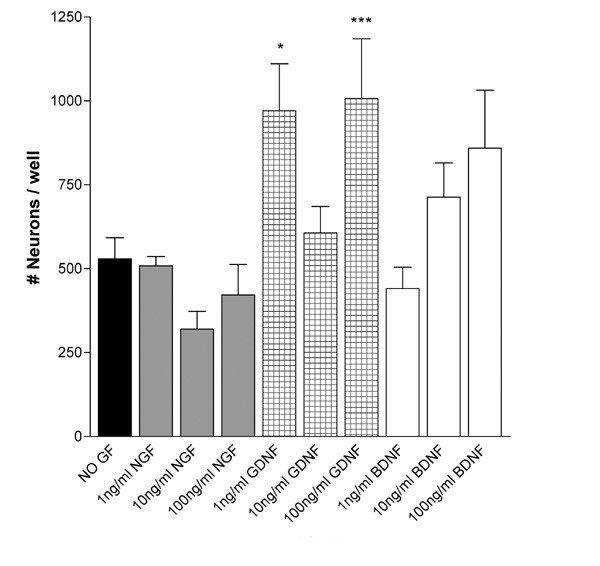
NGF, GDNF and BDNF and TG neuronal surival. All NF-H-immunoreactive neurons were counted for each growth factor-treated TG culture (n = 9 no growth factor; n = 3 all other conditions) and compared with the control (no growth factor-treated) TG cultures to assess neuronal survival at day 5 post-plating (* p < 0.05, *** p < 0.001).